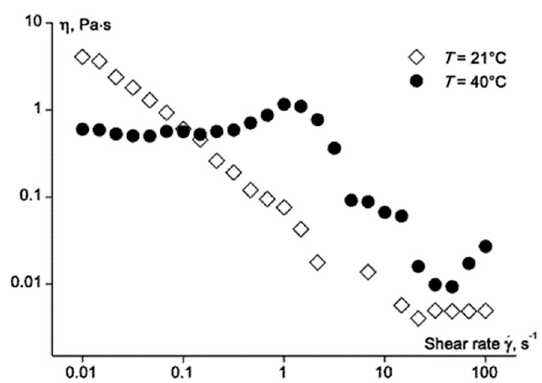
Figure 9. The dependence of the viscosity on the shear rate for 15 wt.% CL-PiPrOx in water at different temperatures.